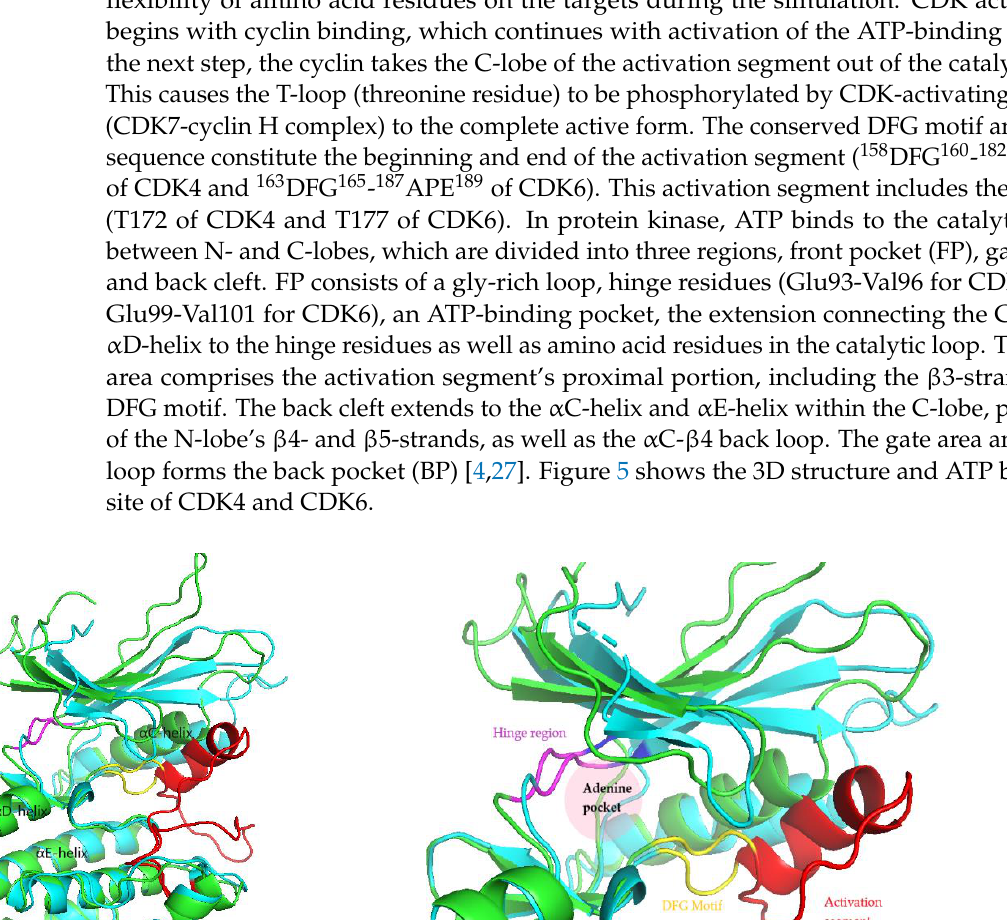
Figure 6. The RMSF of the amino acid residue of CDK4 during the MD simulation.